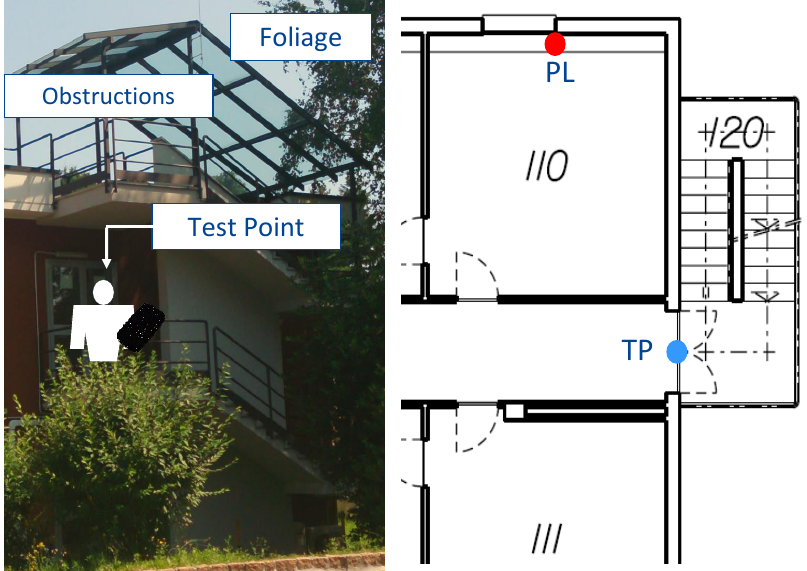
Figure 3. Partially-obstructed scenario selected for testing the improvements brought by a single pseudolite. Marker “TP” indicates the position of the static